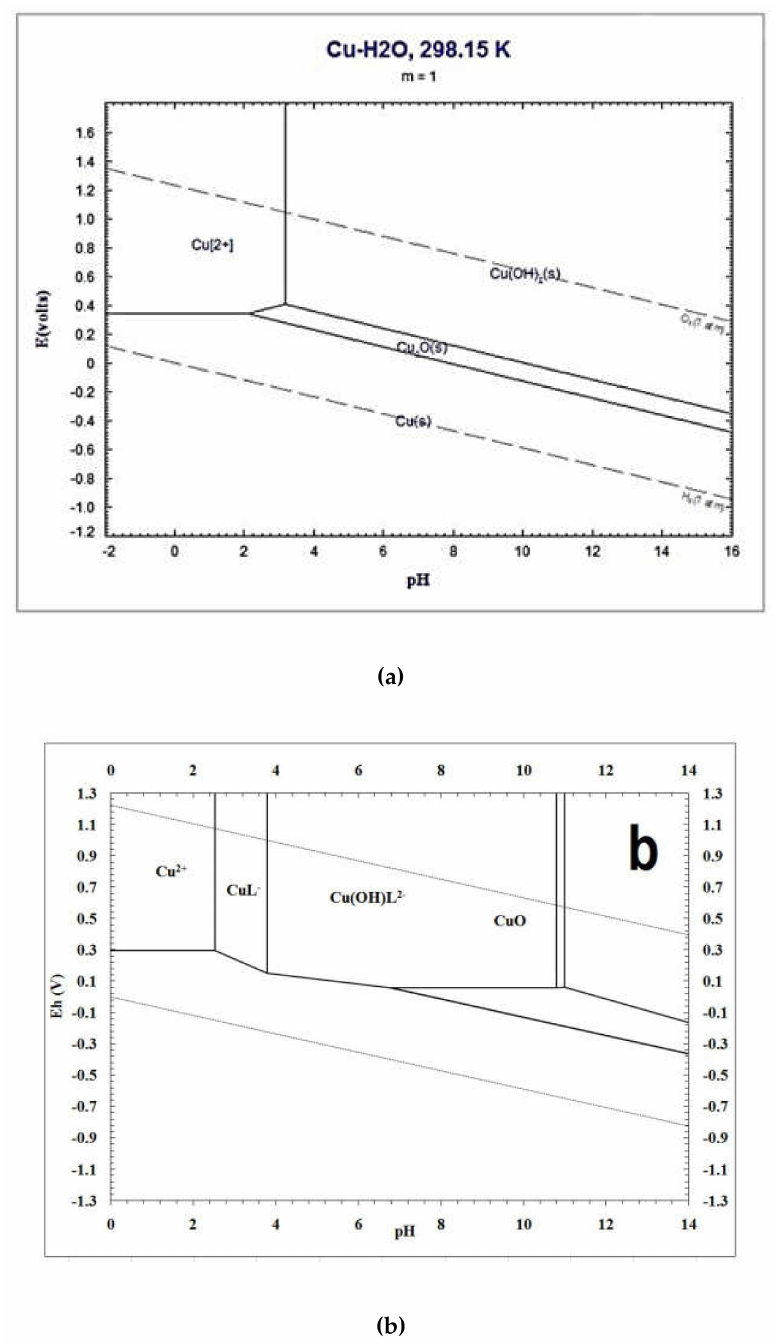
Figure 6. Pourbaix diagram for (a) Cu-H 2 O system; (b) Cu-H 2 O-citrate system at 298 K (total copper activity = 1 M, total citrate activity = 0.667